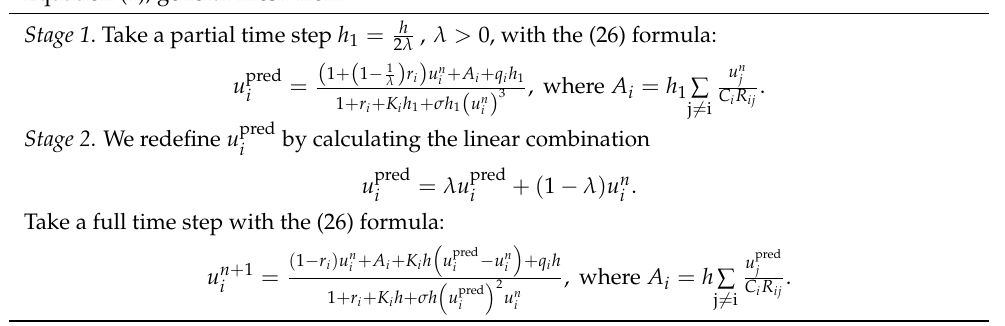
Algorithm 7: (Algorithm 4) 2-stage pseudo-implicit method for the diffusion-reaction Equation (1), general-mesh